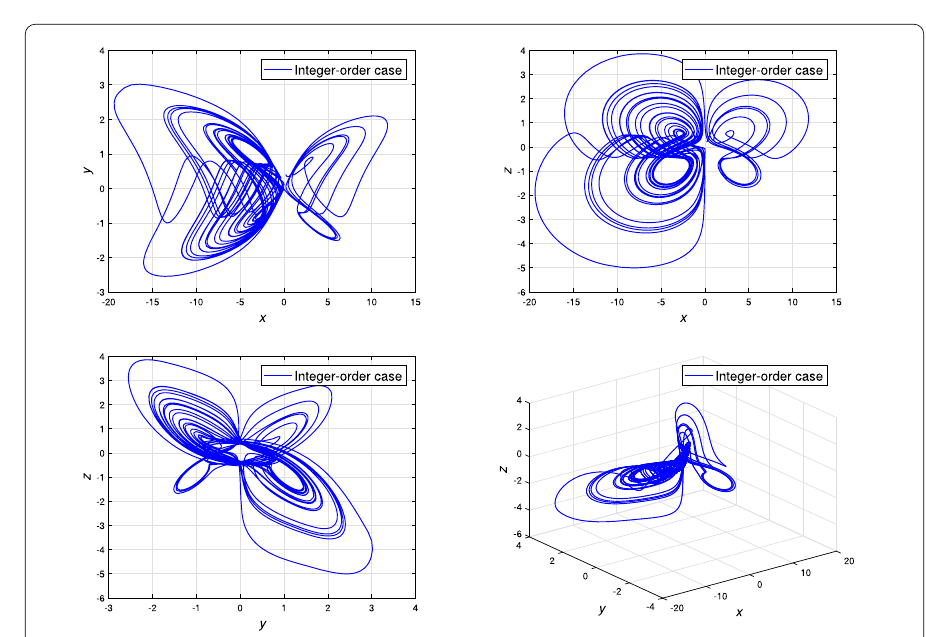
Figure 8 State variables of the integer-order model (16) in the